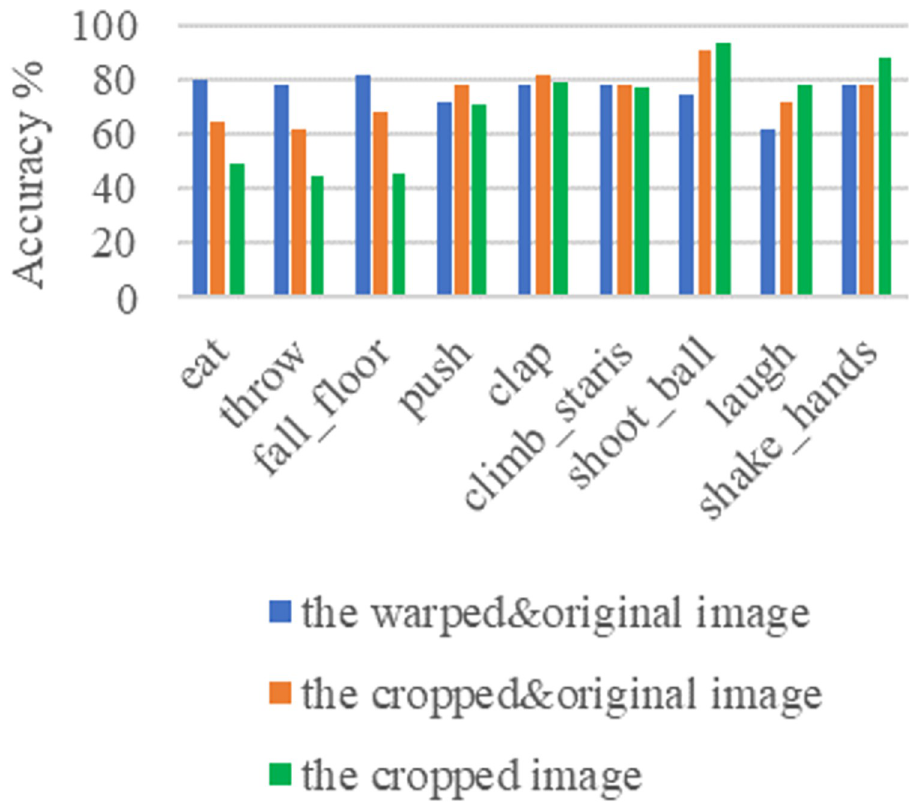
Fig 17. Some typical class accuracy display under different inputs on